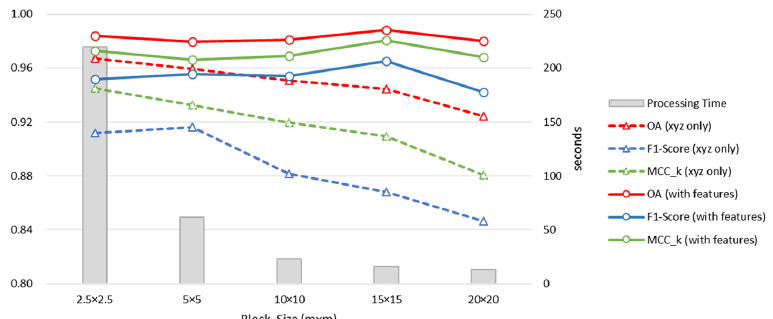
Figure 4. Classification results of PointNet on ALS point clouds with different block sizes.